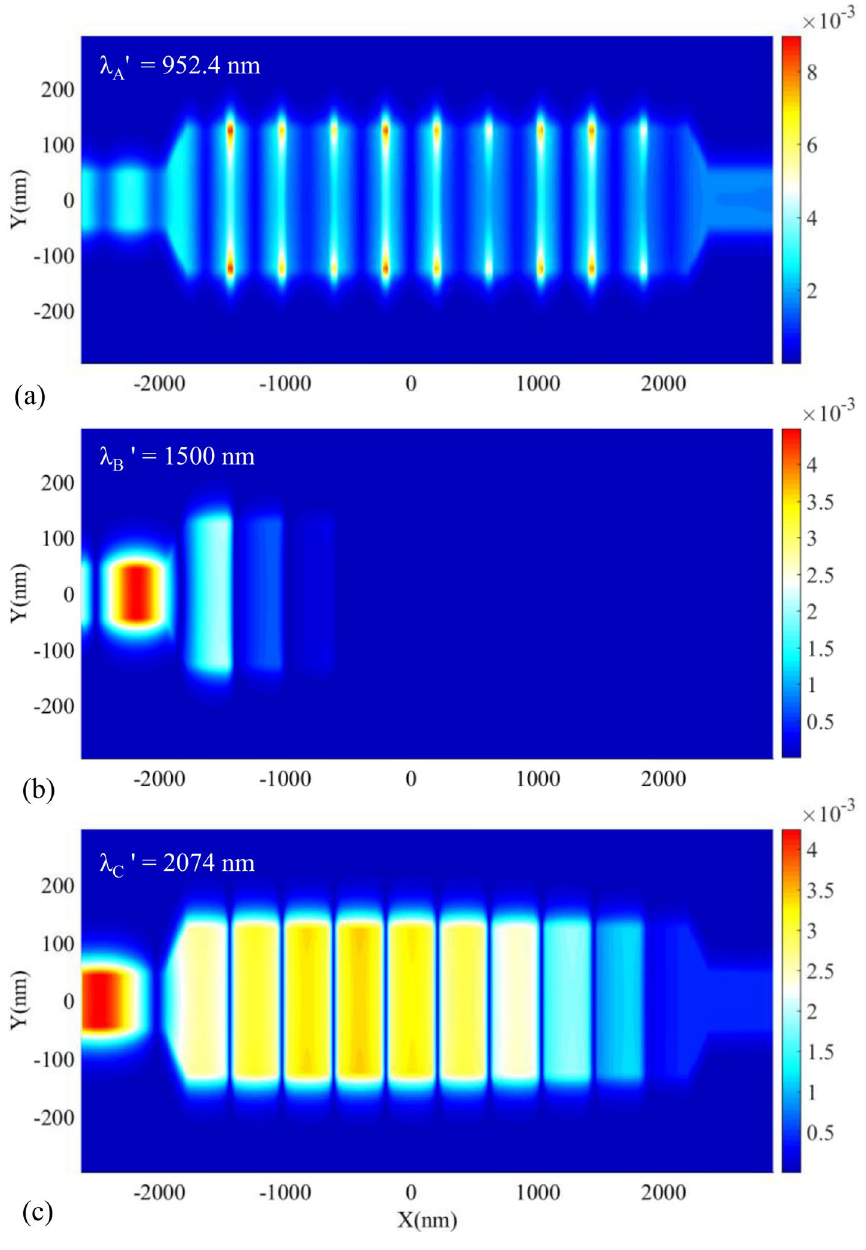
Figure 12. Field profile of | H z | for the proposed biosensor II at the wavelength of ( a ) λ A’ , ( b ) λ B’ , ( c ) λ C’